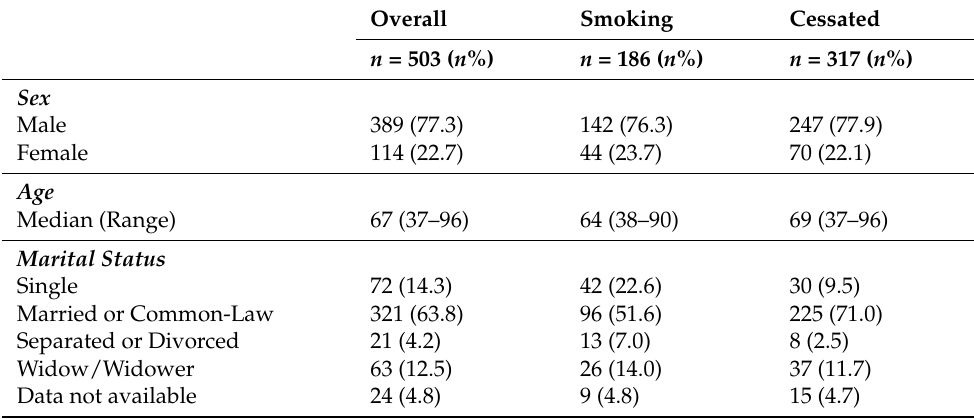
Table 1. Sociodemographic characteristics of head and neck cancer patients ( n = 503) by